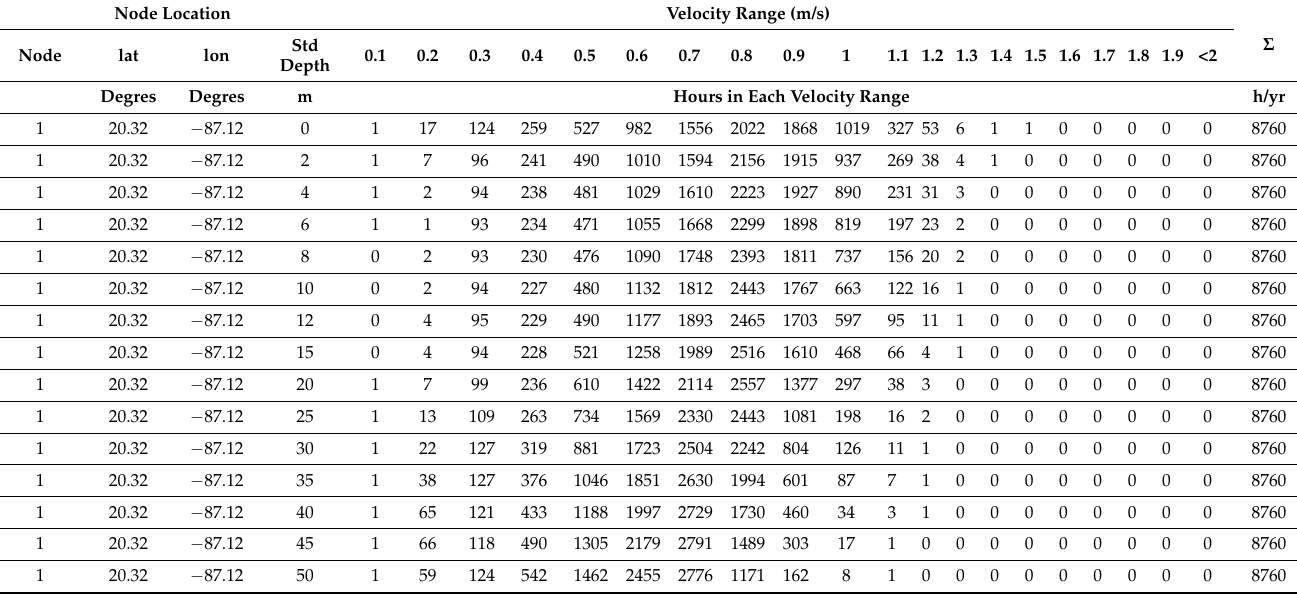
Table A1. Example of the Organization of Data for Each Node and Depth, Node 1.